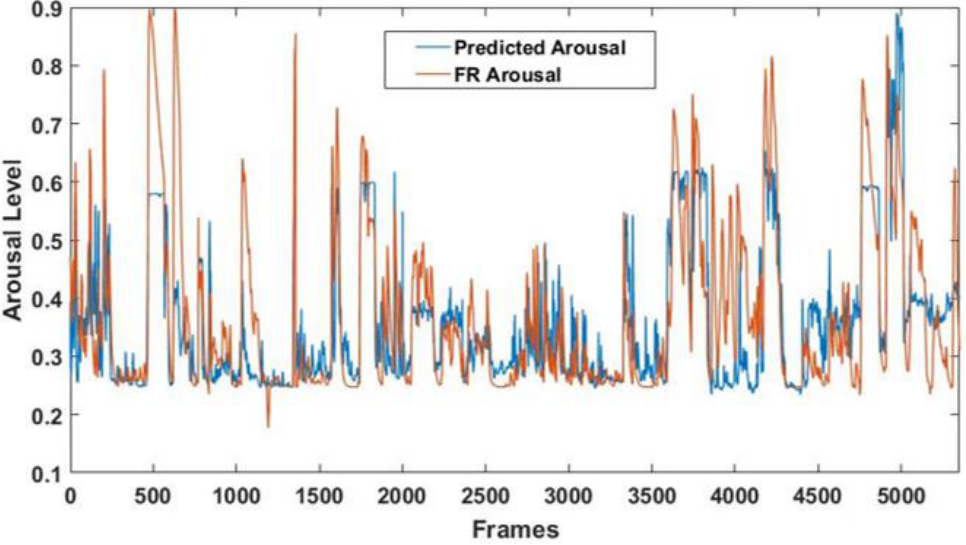
Figure 11. Arousal levels detected throughout the entire experimental session. The blue line repre- sents the arousal predicted by the GLM model, and the red line represents the arousal detected by the FaceReader 7 software.